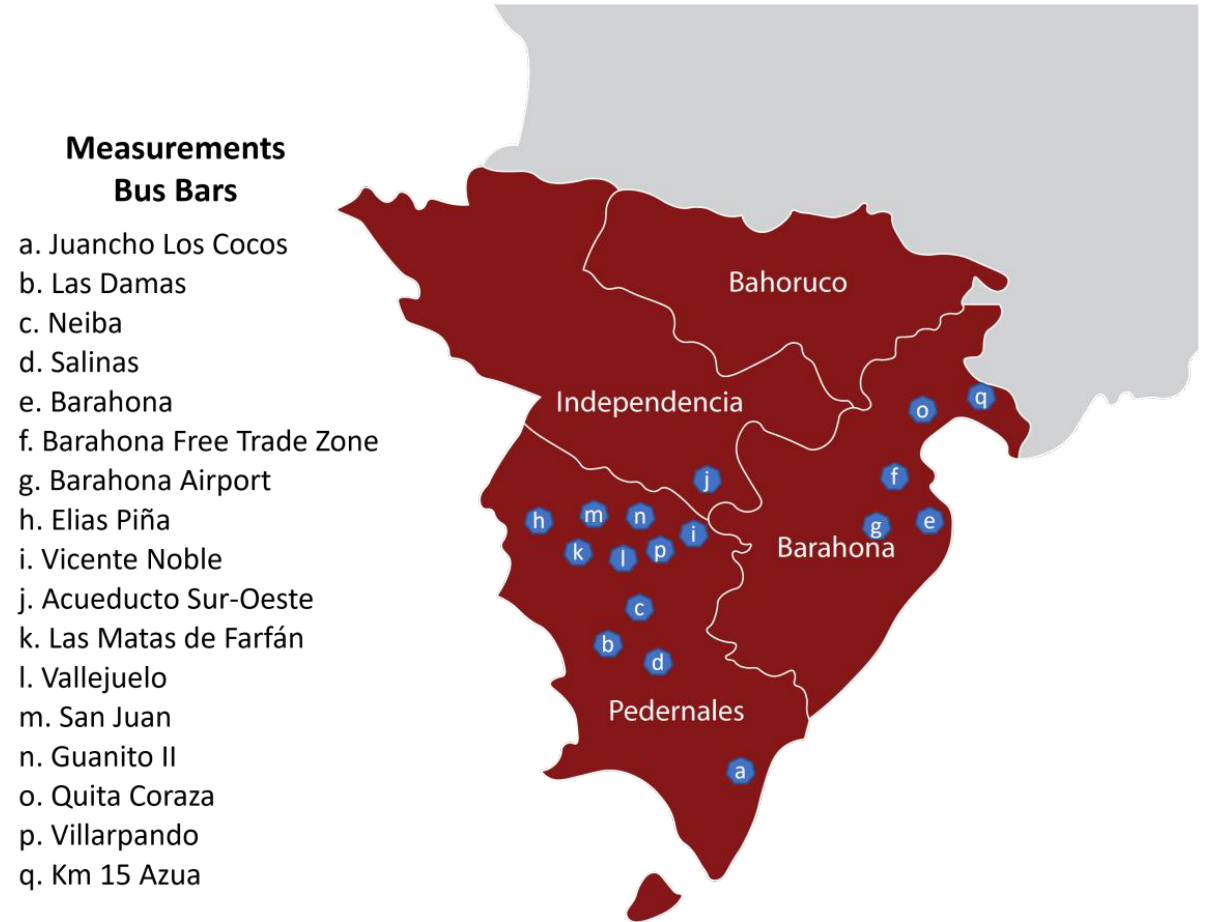
Figure 3. Points of measurement of power flow and electricity demand in the southern part of the country.